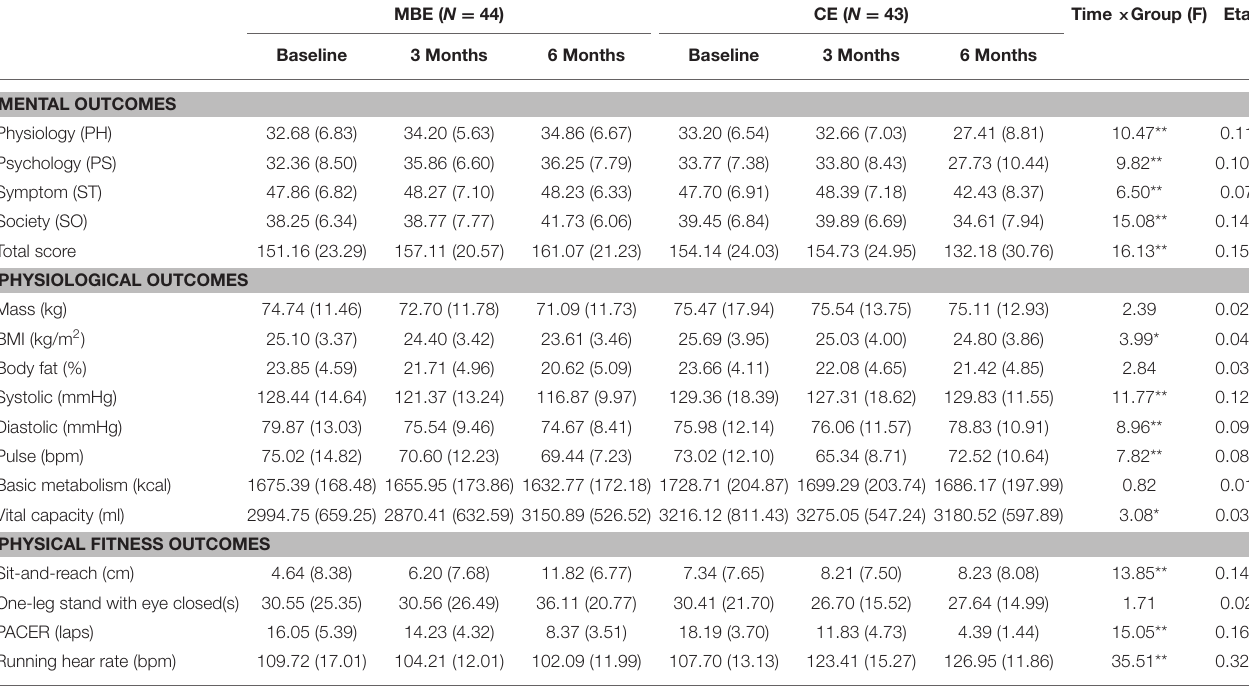
TABLE 3 | Comparison of the two groups at baseline, 3 and 6 months by ANOVA repeat measures. MBE ( N = 44) CE ( N =